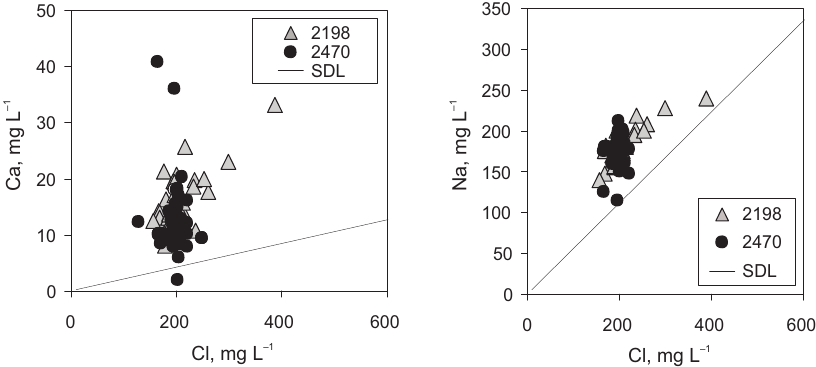
Fig. 7. The concentrations of Na + and Ca 2+ plotted against chloride concentration in wells 2198 and 2470. SDL (cid:150) seawater dilution